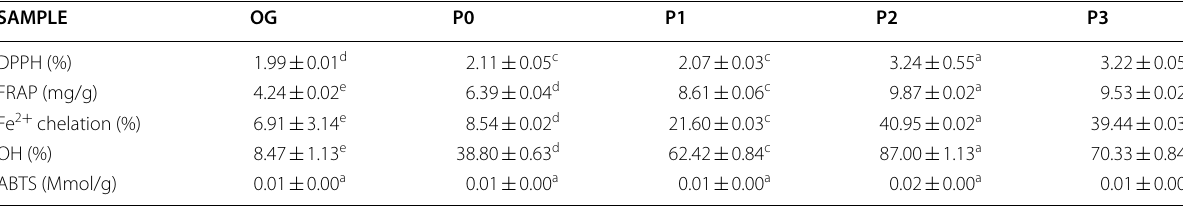
Values are mean of three determinations other ( p 0.05) ≤ Keys: P0 Full fat milk 30%, peanut 25%, soybean oil 15%, sugar 28%, mineral mix 2%, P1 = soybean oil 5%, sugar 10%, moringa leaves 2%); P2